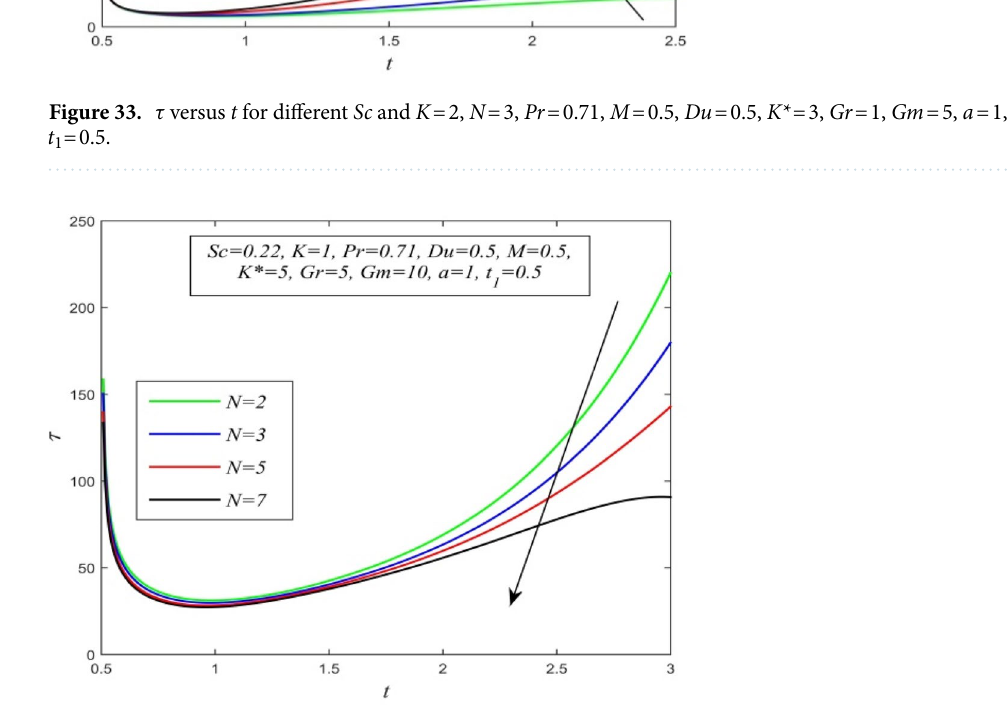
Figure 34. τ versus t for different N and Sc = 0.22, K = 1, Pr = 0.71, M = 0.5, Du = 0.5, K* = 5, Gr = 5, Gm = 10, a = 1, t 1 =